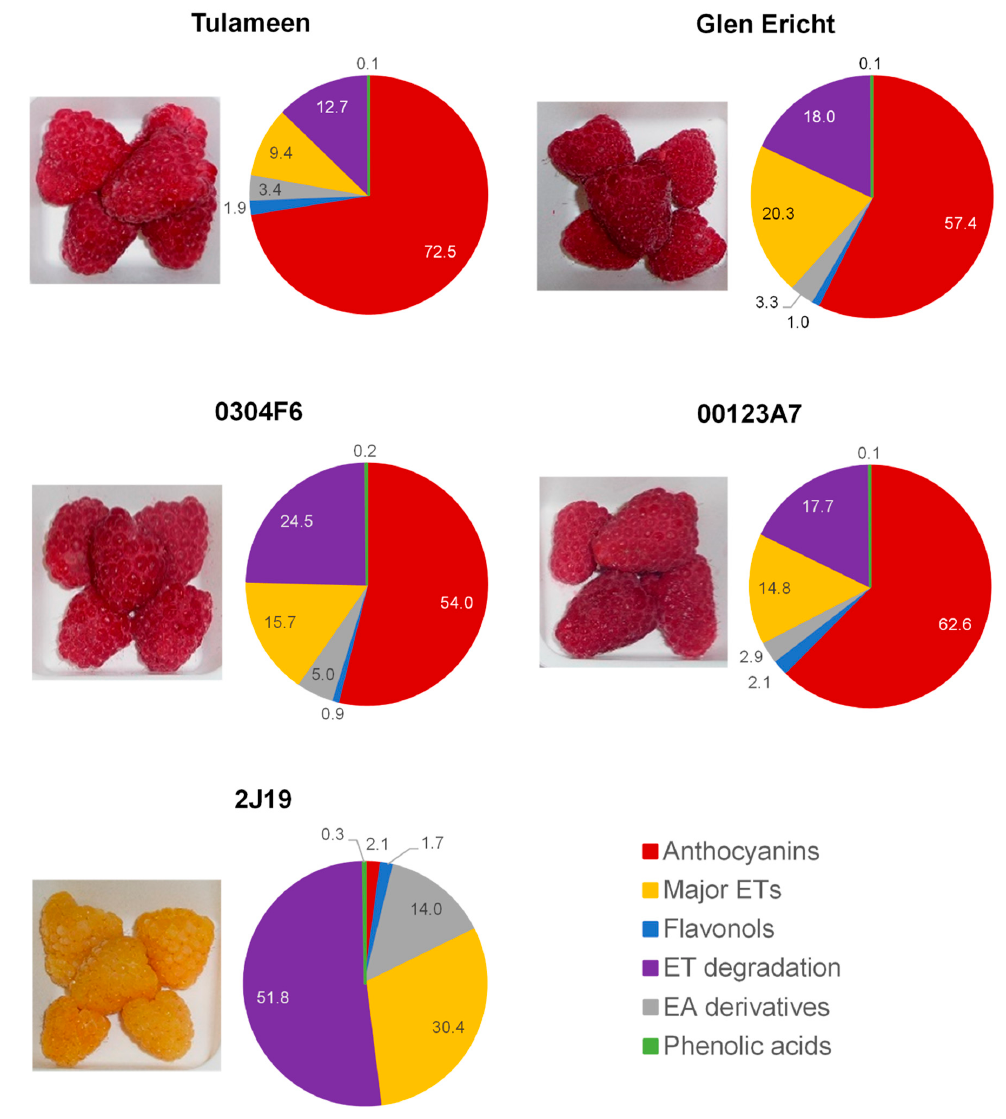
Figure 1. Relative phenolic composition of raspberry GIB fractions. Raspberry cultivars Glen Ericht and Tulameen and genotypes 2J19, 00123A7 and 0304F6 were submitted to in vitro digestion and the recovery of phenolics and identification on degradation products after digestion was achieved using LC-PDA-MS analysis. Values are percentages of total phenolic content, and detailed composition of the GIB fractions is presented in Supplementary Table S3A,B. EA—Ellagic acid,